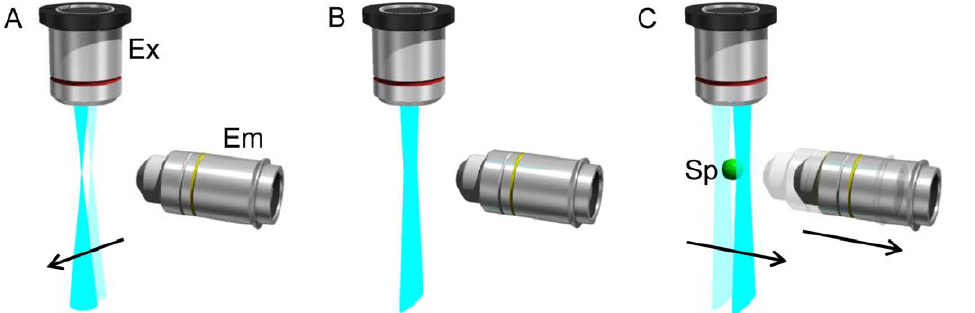
Figure 1. Schematic of ezDSLM (A, B). Line scan (A) to make an ‘apparent’ light-sheet (B). This step is similar to that in the conventional DSLM. (C) Scan of the light-sheet to obtain three-dimensional image of specimen. The objective for emission detection is synchronized with the movement of the light-sheet scanning. Ex, objective for excitation; Em, objective for emission detection; Sp, specimen.